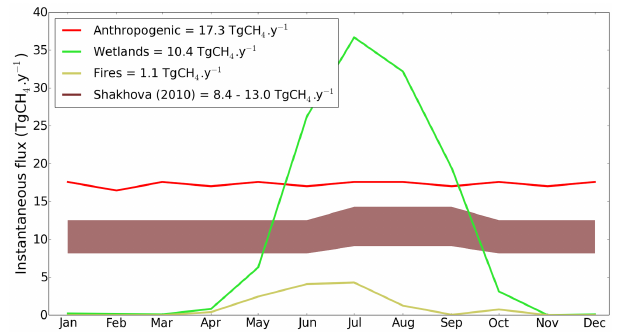
Figure 2. Seasonal cycle of prior emissions as used in the model